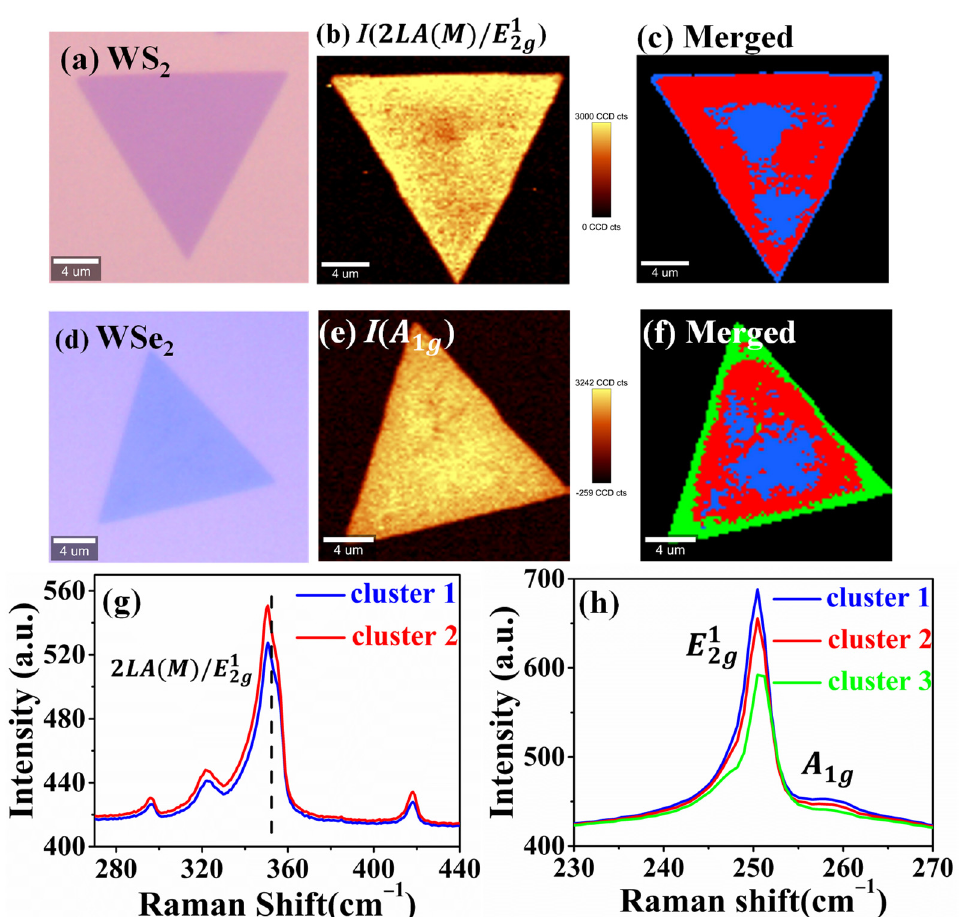
Figure 5. The k-means clustering Raman analysis of monolayer WS 2 and WSe 2 on Si/SiO 2 substrate. ( a , d ) the optical images of triangular WS 2 and WSe 2 with uniform optical contrast, respectively. ( b , e ) The Raman image of the characteristic Raman peak sum intensity ( 2𝐿𝐴(𝑀)/𝐸 (cid:2870)(cid:3034)(cid:2869) for WS 2 and 𝐸 (cid:2870)(cid:3034)(cid:2869) for WSe 2 . ( c , g ) Color-coded Raman image with two groups and the correlated mean Raman spectra of WS 2 . ( f , h ) Color-coded Raman image and mean Raman spectra of WSe 2 , respectively.